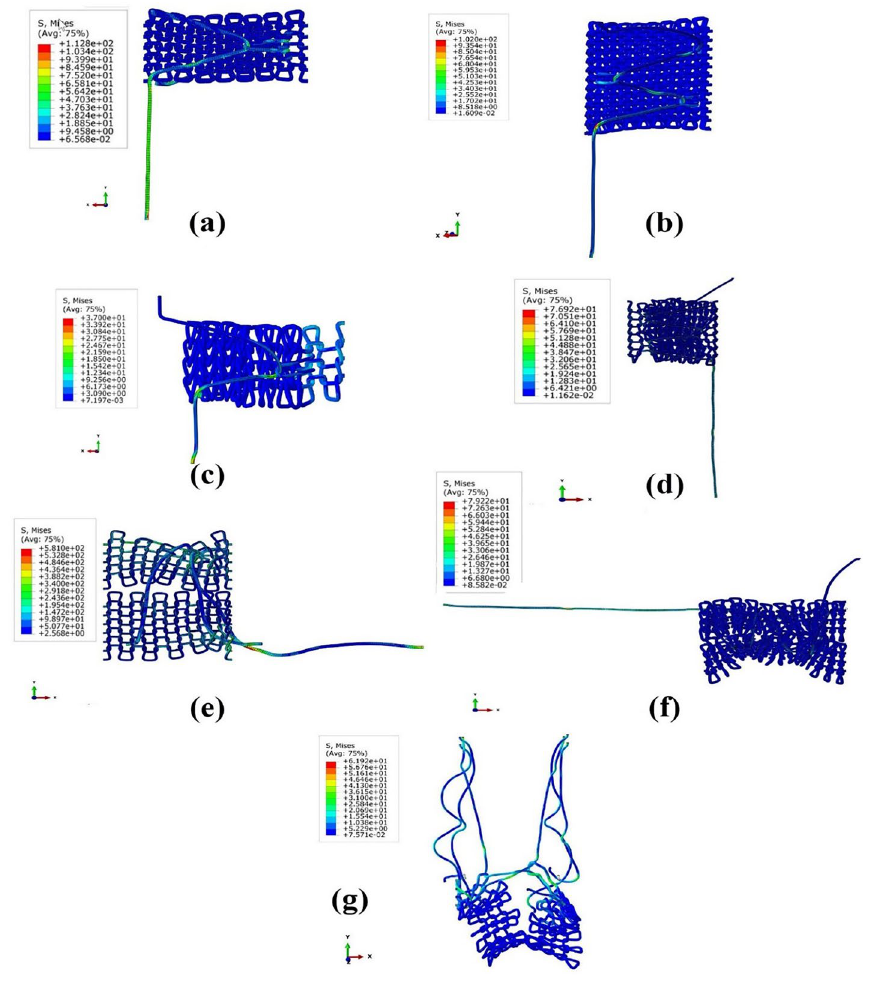
Fig. 5 Stress contours of the meso models during pull out test, a T1 in course direction, b T1 with two unit-cells in course direction, c T3 in course direction, d T3 with two unit-cells in course direction, e T5 in wale direction, f T5 with two unit-cells in wale direction, g T4 in course direction